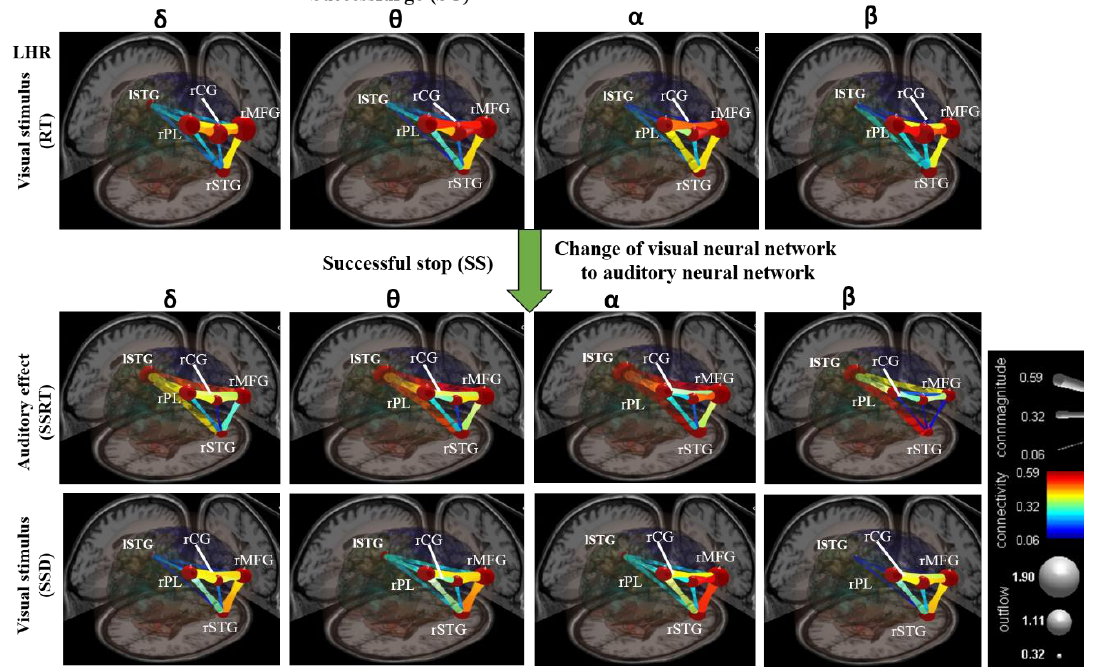
Figure 10. The design of visual and auditory cross-model neural networks under human inhibitory control of left-hand response (LHR). The neural network between five brain regions, including left superior temporal gyrus (lSTG), right superior temporal gyrus (rSTG), right cingulate gyrus (rCG), right middle front gyrus (rMFG), and right parietal lobe (rPL). The green arrow shows the change of the visual neural network to the auditory neural network. Color bars shows the scale of the connectivity strength; statistical threshold at p < 0.01. The outflow was obtained between two dipole sources. The gray node shows the high and low outflow strength between the two dipoles. Connectivity (edge color mapping): The color of the edges was mapped to connectivity strength (amount of information flow along that edge). Red = high connectivity and green = low connectivity. ConnMagnitude (edge size mapping): The size of edges of the graph (connecting “arrows”) was mapped to connectivity magnitude (i.e., absolute value of connectivity strength).